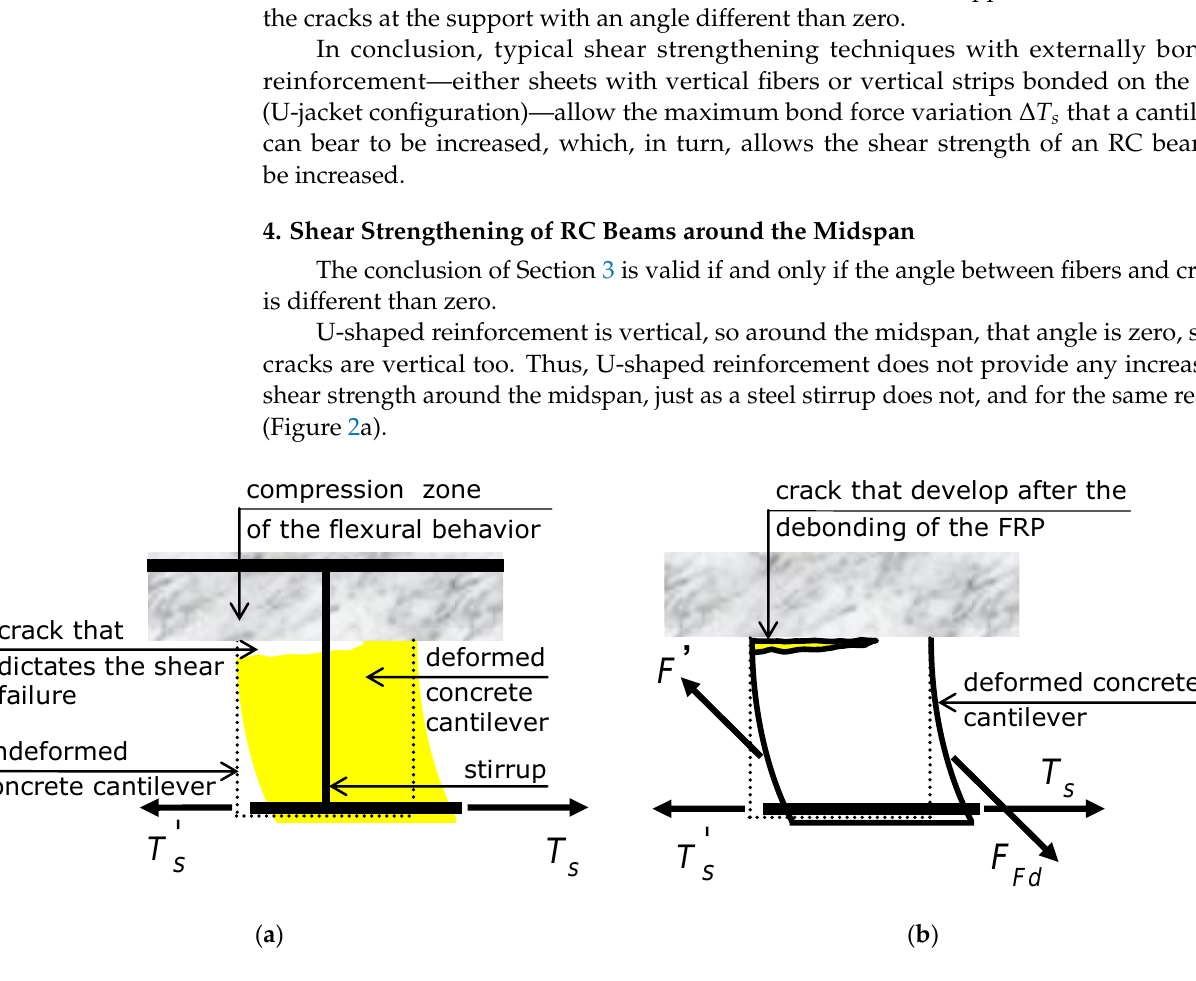
Figure 2. Concrete cantilever that dictates the capacity of the RC beam. ( a ): beam without external reinforcement. ( b ): beam with side-bonded FRP reinforcement, whose fibers are at ±45° (the sign of the angle depends on which of the two sides of the web the fibers are bonded to).